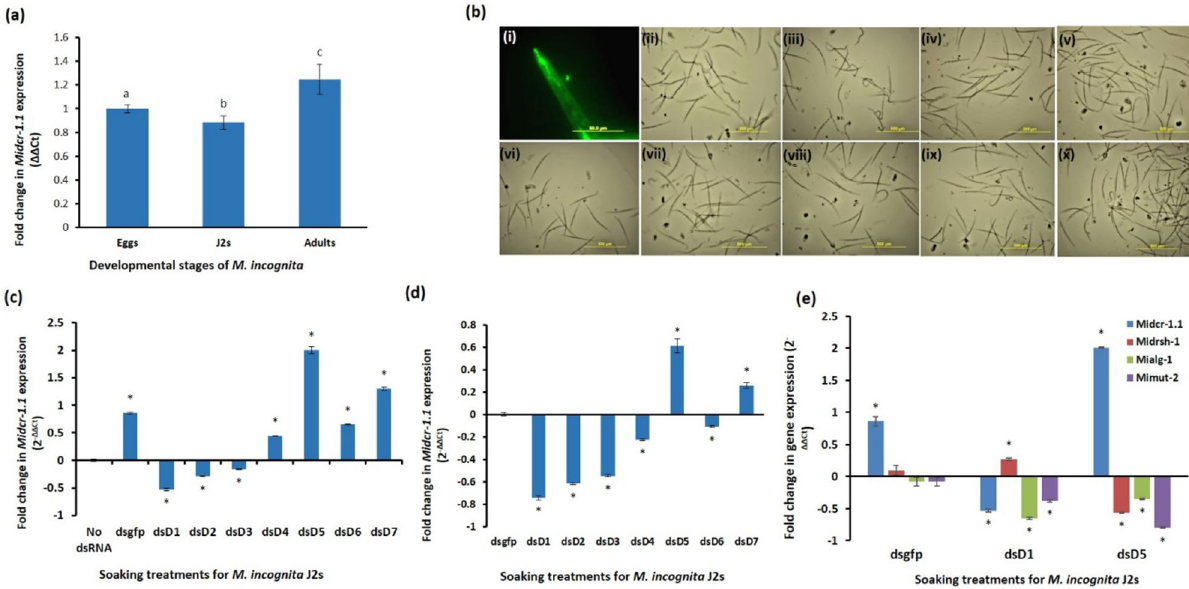
Figure 5. Expression and RNAi of Midcr-1.1 in M. incognita. (a) Fold changes in expression of Midcr-1.1 in eggs, J2s and adult females. (b) Phenotypes of J2s 16 h after soaking in buffers with or without dsRNA (i) Representative J2 with the gut, stylet and granules showing uptake of FITC (ii) J2s soaked without dsRNA (iii) J2s treated with dsgfp (iv–ix), J2s treated with seven dsRNAs namely dsD1 (iv) , dsD2 (v), dsD3 (vi), dsD4 (vii), dsD5 (viii), dsD6 (ix), and dsD7 (x). (c,d) Fold change in Midcr-1.1 expression in dsRNA-treated J2s relative to expression in J2s treated without dsRNA (c) and relative to expression in dsgfp-treated J2s (d). (e) Expression of Midcr-1.1, Midrsh-1, Mialg-1 and Mimut-2 in J2s treated with dsgfp, dsD1 and dsD5. Means significantly different from the controls are indicated by different letters or “*”; they were determined at p < 0.05 using T-test (two-tailed) with three replicates. Error bars represent standard